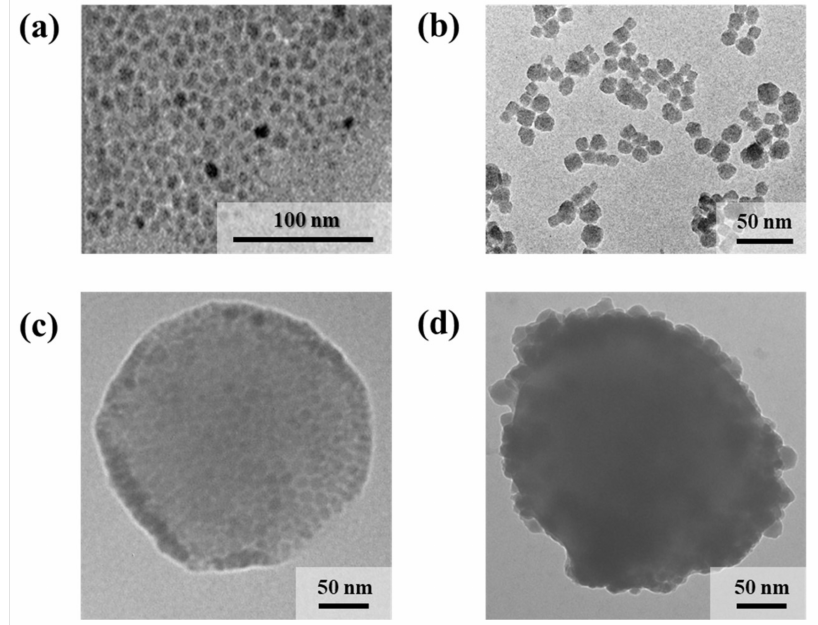
Figure 2. The TEM images of ( a ) Fe 3 O 4 NPs; ( b ) PB NPs; ( c ) Fe 3 O 4 @PLA NPs, and ( d )